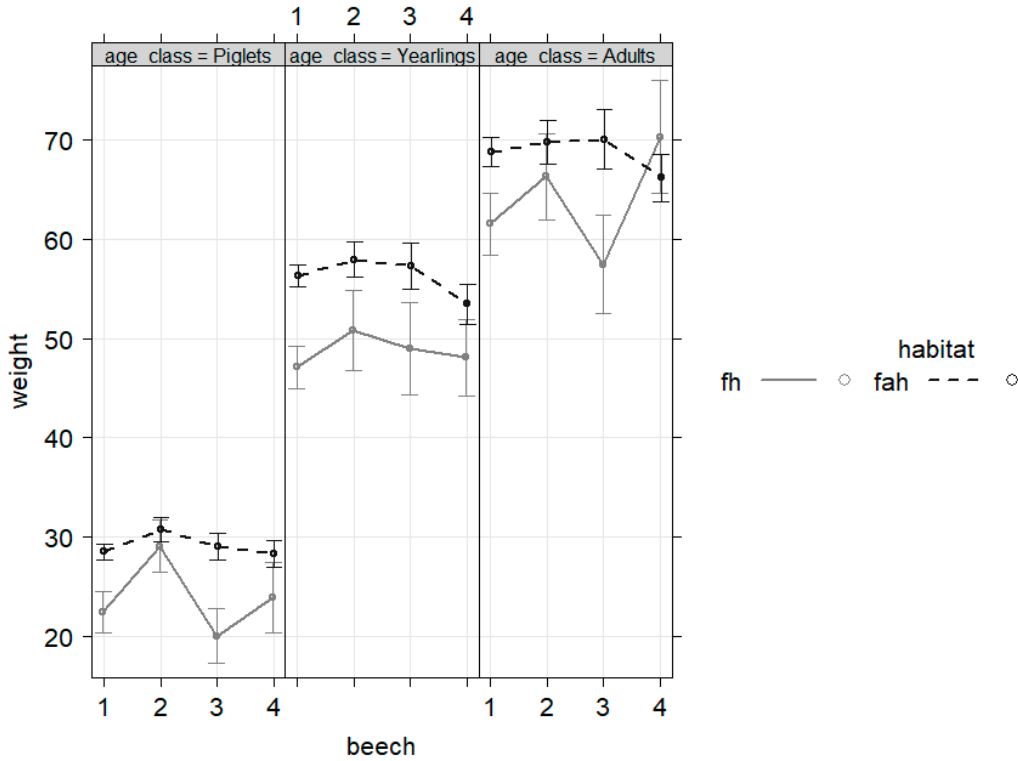
Figure 3. Strong beech mast (numbers represent levels according to categorization from forestry commission office Oerrel, Lower Saxony; 1 = no, 2 = part, 3 = half, 4 = full mast) resulted in (significantly) positive effects on bw only for adult wild boar females in fh ( n = 680, p = 2.77 × 10 − 7 for beech = 4, age = adult, habitat = fh).